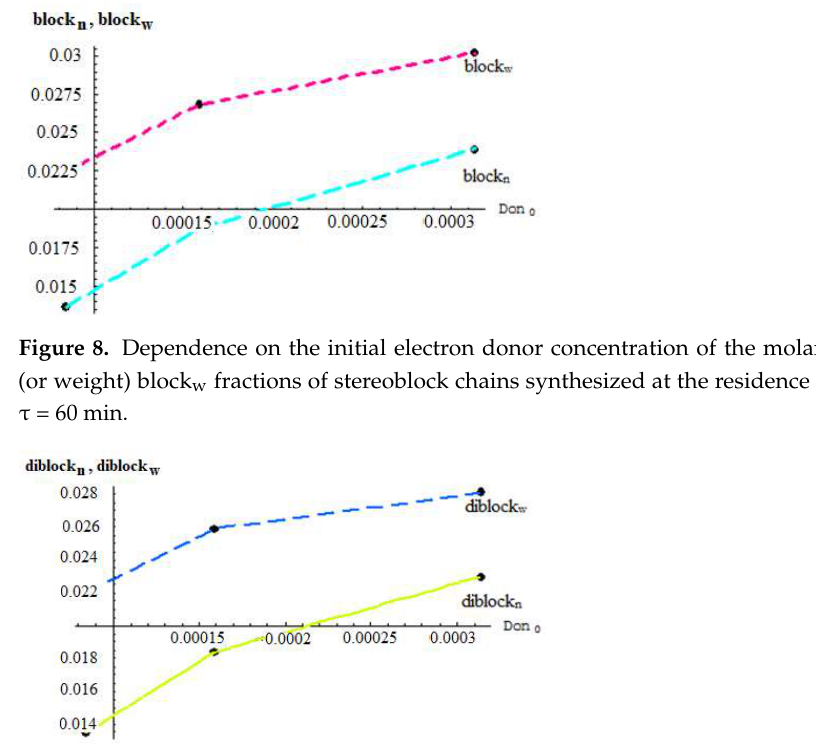
Figure 9. Dependence on the initial electron donor concentration of the molar diblock n and weight diblock w fractions of diblock chains synthesized at the residence time in the reactor τ = 60 min.